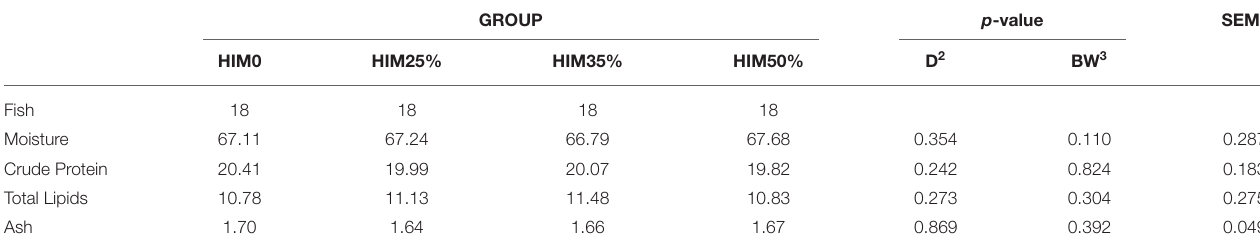
TABLE 4 | Proximate composition (g/100g of wet weight) of the filets of the gilthead sea bream fed with the four exerimental diets. GROUP p -value SEM 1 HIM0 HIM25% HIM35%